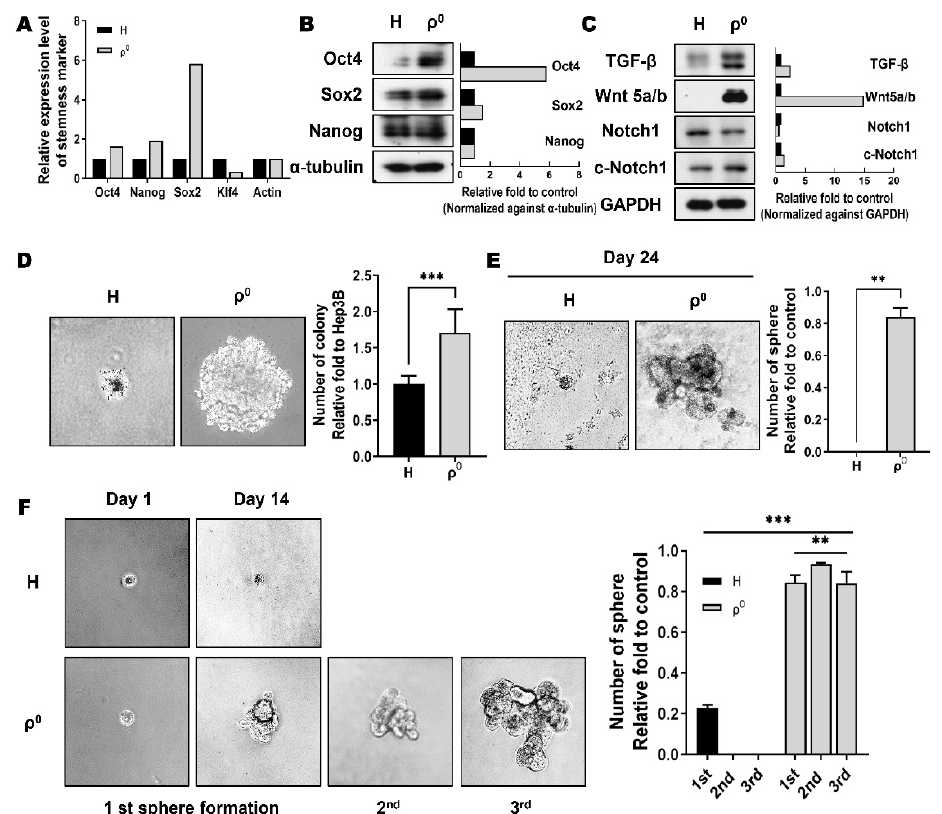
Figure 1. Mitochondria dysfunctional ( ρ 0 ) cells exhibit self-renewal properties. ( A ) Expression of embryonic stem cell (ESC)-related transcription factors was analyzed by real-time PCR and ( B ) Western blotting. Graph showing respective molecule levels normalized to the loading control. Black box: Hep3B. Grey box: Hep3B/ ρ 0 . ( C ) The expression of self-renewal-related proteins was detected by Western blot analysis. Graph showing respective molecule levels normalized to the loading control. Black box: Hep3B. Grey box: Hep3B/ ρ 0 . ( D ) Colony formation assay. Hep3B ( H ) and Hep3B/ ρ 0 ( ρ 0 ) cells were incubated for 4 weeks in agarose-coated 35 mm dishes (*** p < 0.0005). ( E ) Analysis of sphere formation capability of Hep3B and Hep3B/ ρ 0 cells. Cells were incubated for 24 d in anchorage-independent conditions (** p < 0.0005). ( F ) Self-renewal property was also examined through serial sphere forming in Hep3B and Hep3B/ ρ 0 cells (** p < 0.005, *** p < 0.0005).